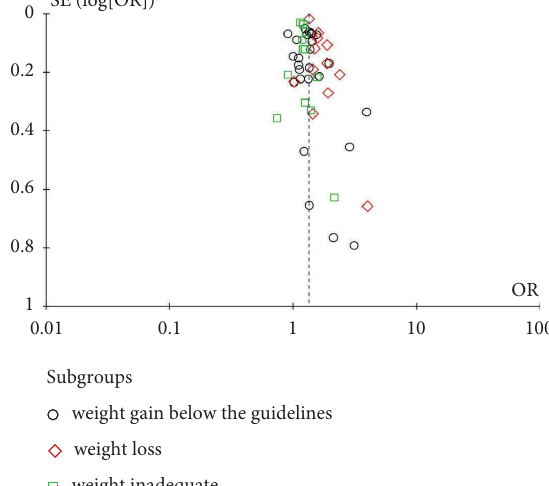
Figure 10: Funnel plots for efect of weight gain below the guidelines with SGA for overall obesity, inadequate weight, and weight